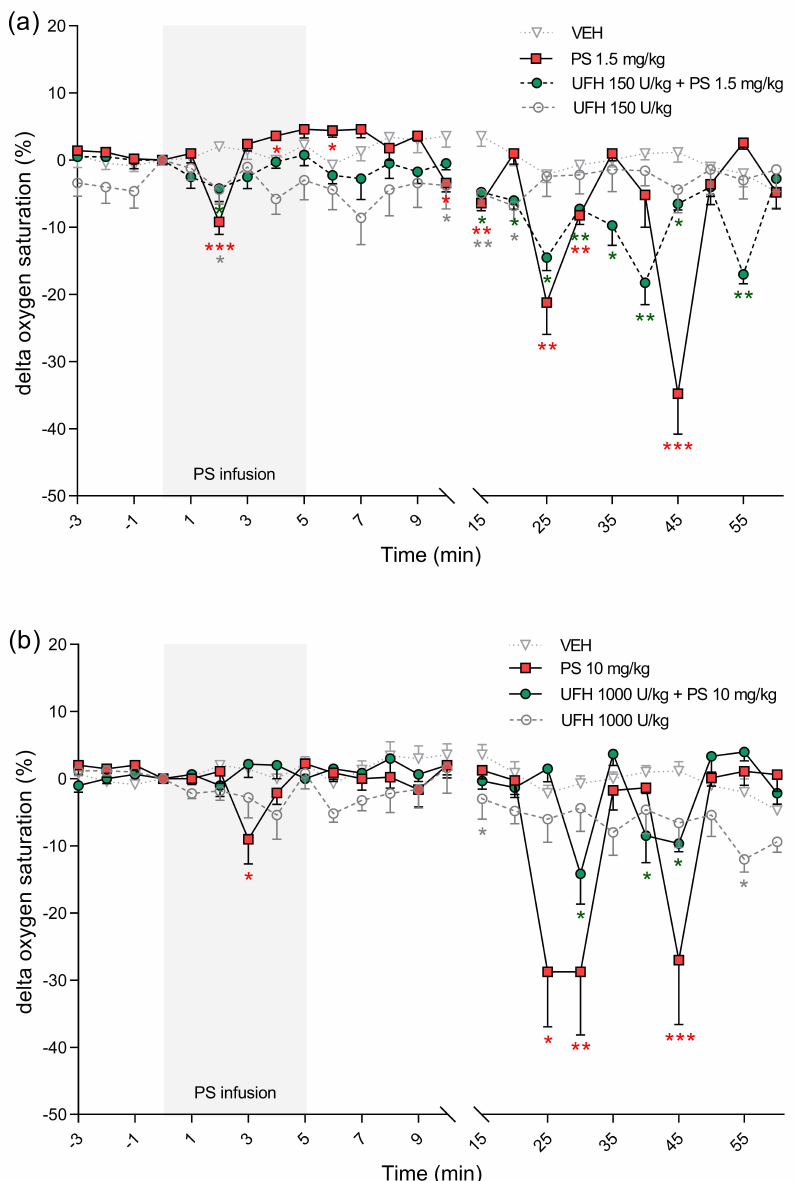
Figure 8. The effects of protamine sulfate (PS) and its complexes with unfractionated heparin (UFH) on blood oxygen saturation. The course of blood oxygen saturation was tracked for 60 min after short–duration intravenous infusion (5 min; 2 mL/h) of PS at a dose of 1.5 ( a ) or 10 mg/kg ( b ) following intravenous administration of vehicle (VEH, 1 mL/kg) or UFH (150 or 1000 U/kg, 1 mL/kg). Results are shown as means (lines) with SEMs. The blood oxygen saturation values at 0 min of the experiment were 82 (72–89) for VEH, 82 (73–86) for PS 1.5 mg/kg, 85 (81–87) for UFH 150 U/kg + PS 1.5 mg, 85 (84–94) for UFH 150 U/kg, 79 (73–86) for PS 10 mg/kg, 79 (72–89) for UFH 1000 U/kg + PS 10 mg/kg, 87 (80–99) for UFH 1000 U/kg. Note: * p < 0.05, ** p < 0.01; *** p < 0.001 vs. VEH, Kruskal–Wallis ANOVA with Dunn’s post–hoc test, n =